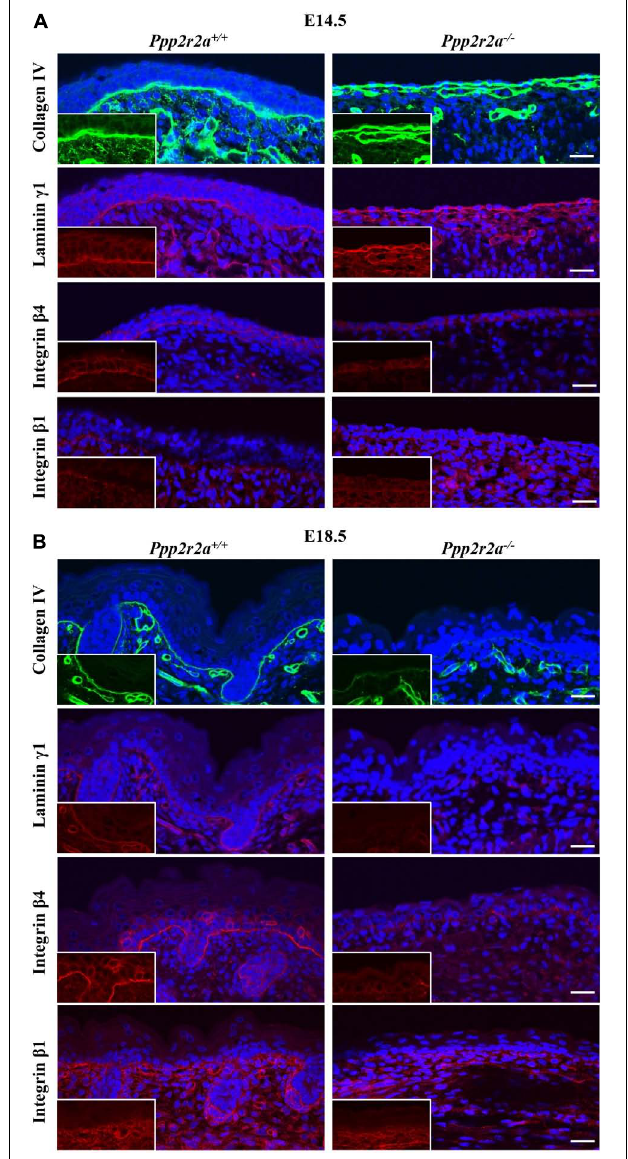
FIGURE 6 | Reduced basement membrane and integrins in Ppp2r2a knockout epidermis. Representative immunofluorescent pictures of Collagen IV (green), Laminin γ 1 (red), Integrin β 4 (red) and Integrin β 1 (red) in Ppp2r2a + / + and Ppp2r2a − / − epidermis at both E14.5 (A) and E18.5 (B) . DAPI is shown in blue. Inserts show a region from each image without the DAPI to highlight the protein labeling. All scale bars = 25 µ m.